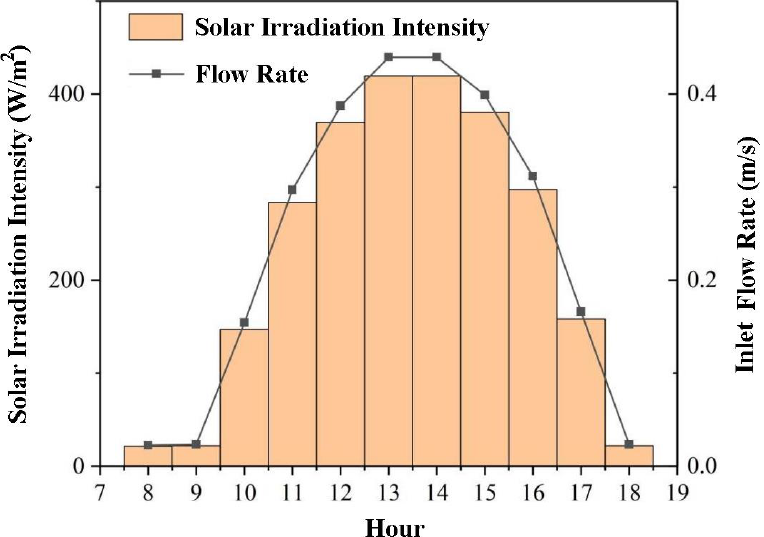
Figure 3. The hourly solar irradiance intensity and inlet